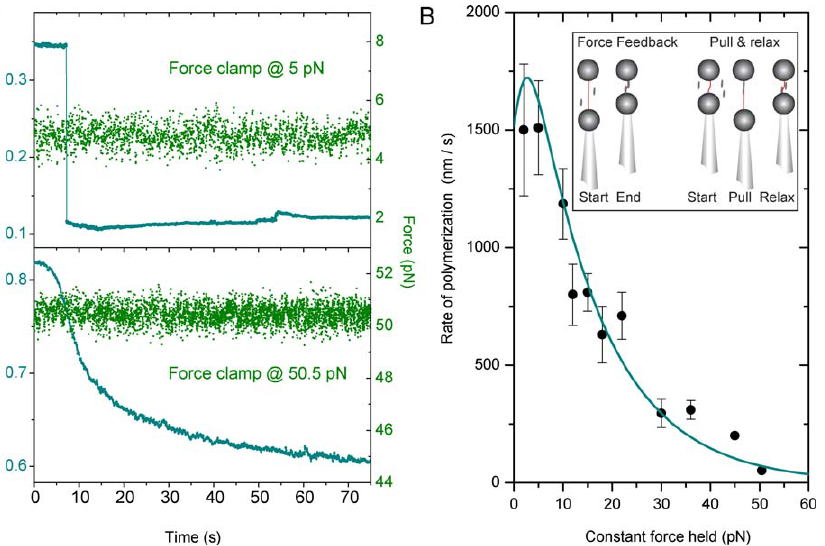
Figure 1. Force-Feedback Experiments on ssDNA in the Presence of VirE2 Proteins (A) Force-feedback time traces of a single ssDNA molecule compacted after VirE2 injection. The blue solid line is the extension (normalized to the contour length of ssDNA), the green line is the constant force signal. Upper panel: force-feedback at 5 pN. Lower panel: force-feedback at 50.5 pN. (B) Polymerization rate k ( f ) of VirE2 proteins as a function of the applied tension on the ssDNA template. At each force, k ( f ) is expressed in nm/s (A). An analysis presented in the Text S1 [section: Rate of polymerization (experimental determination)] allows the rate originating from a single polymerization front to be determined. The observed force-dependence of k ( f ) is overlayed by a theoretical model using known structural parameters of both ssDNA and VirE2-ssDNA complexes (solid line; see main text section: Local binding mode, and Text S1 section: Rate of polymerization (theory)]. The inset shows optical tweezers modes used. Force feedback: the pipette displacement is controlled by the servo-system to maintain a constant tension on the ssDNA during protein injection. Pull and relax: the force is recorded upon movement of the pipette (extending and relaxing the filament in the presence of proteins) without feedback.